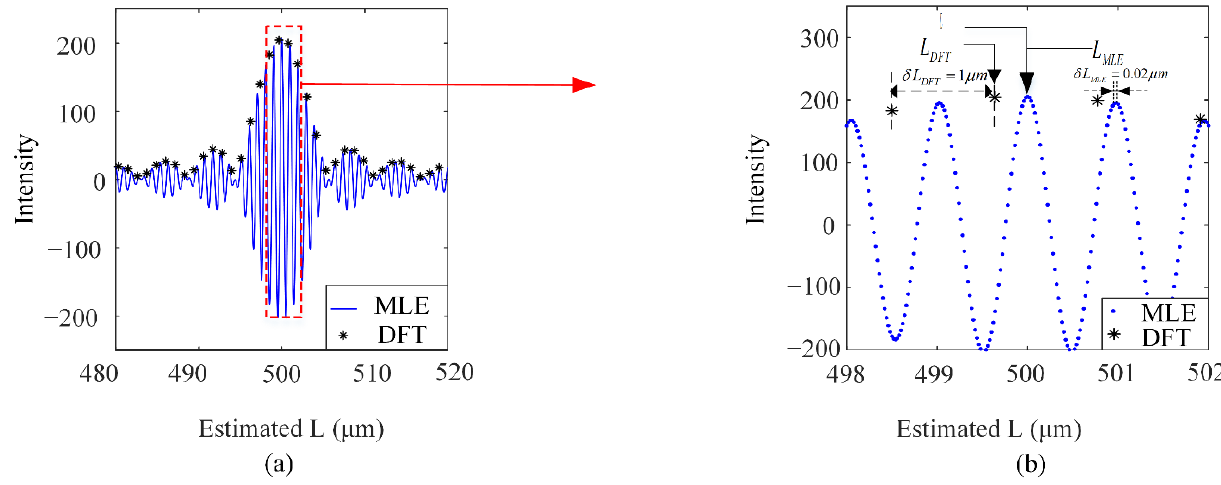
Figure 3. ( a ) The spectrum of FFT and MLE and ( b ) detail of the corresponding spectral peaks (Assuming L = 500 µ m). The detailed diagram corresponding to the spectral peak is shown in Figure